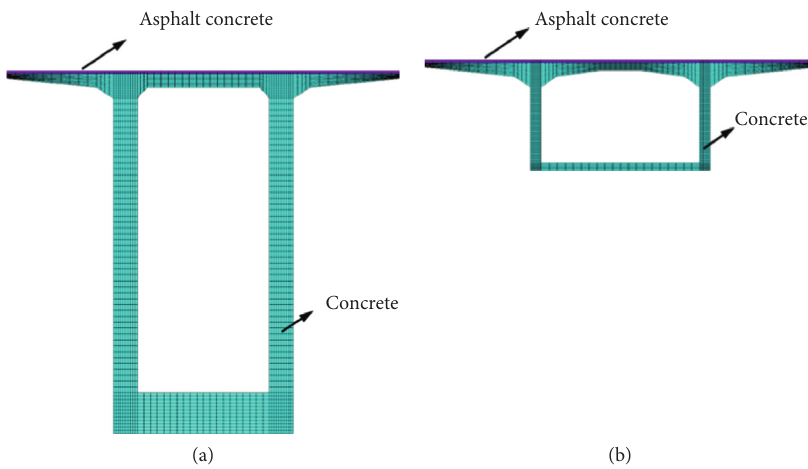
Figure 8: The FEMs of the CBG: (a) section T1 and (b) section